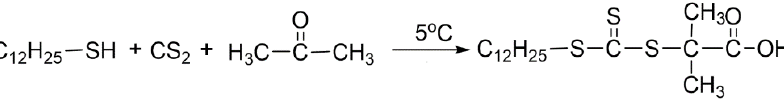
Scheme 1. The synthesis procedure of chain transfer agent, DMPA.